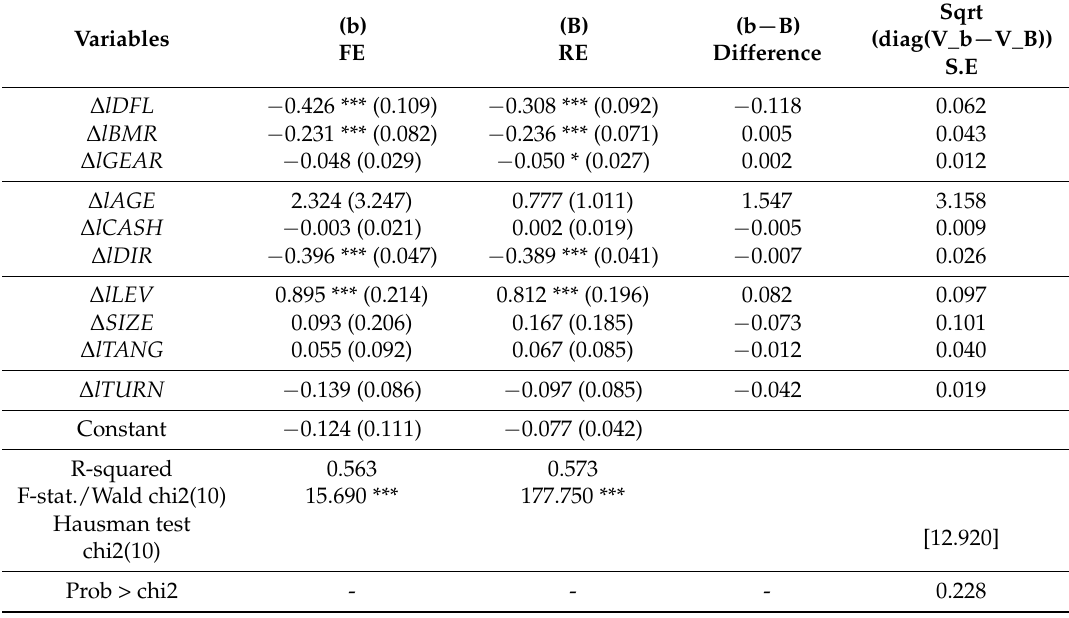
Table A4. Hausman test between the fixed effects model and the random effects model (Model